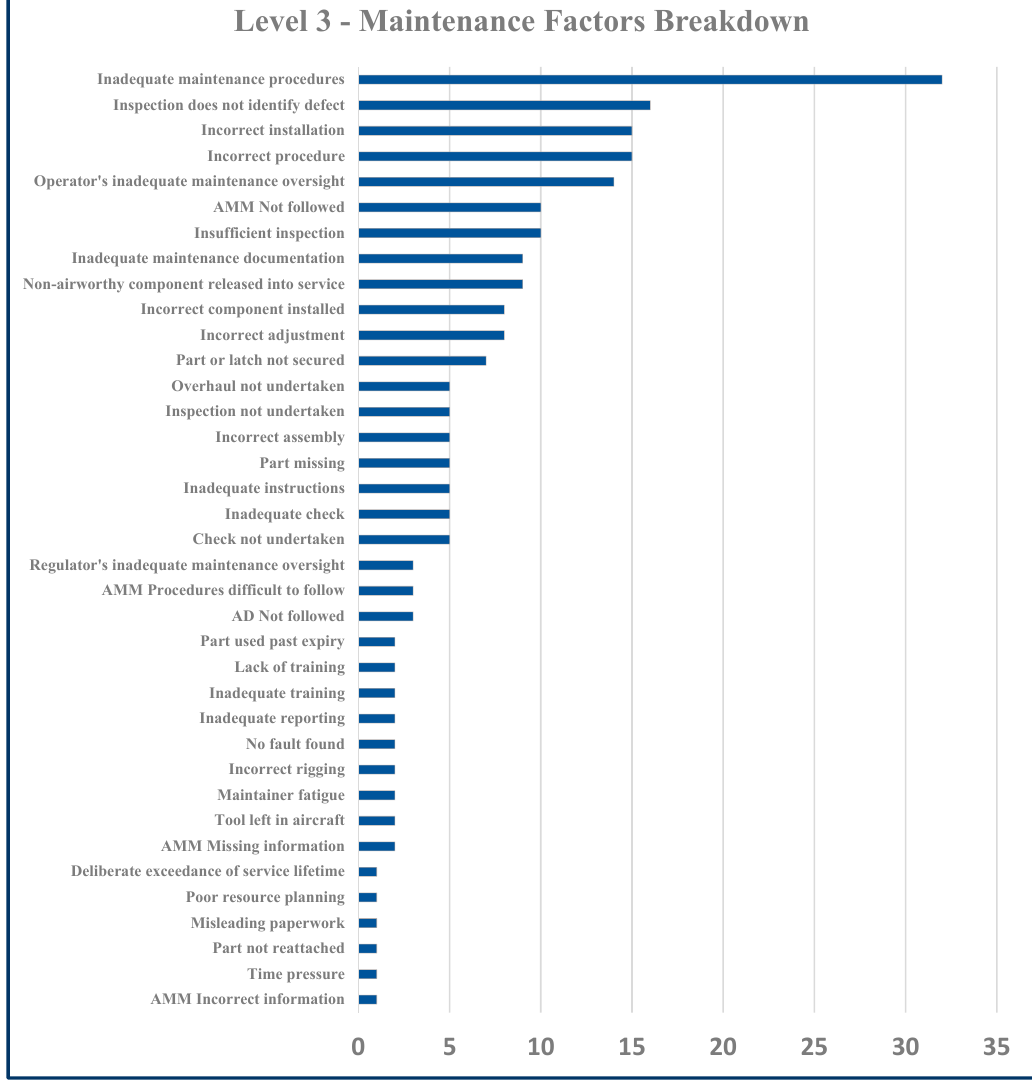
Figure 7. Level 3 top level maintenance factors.